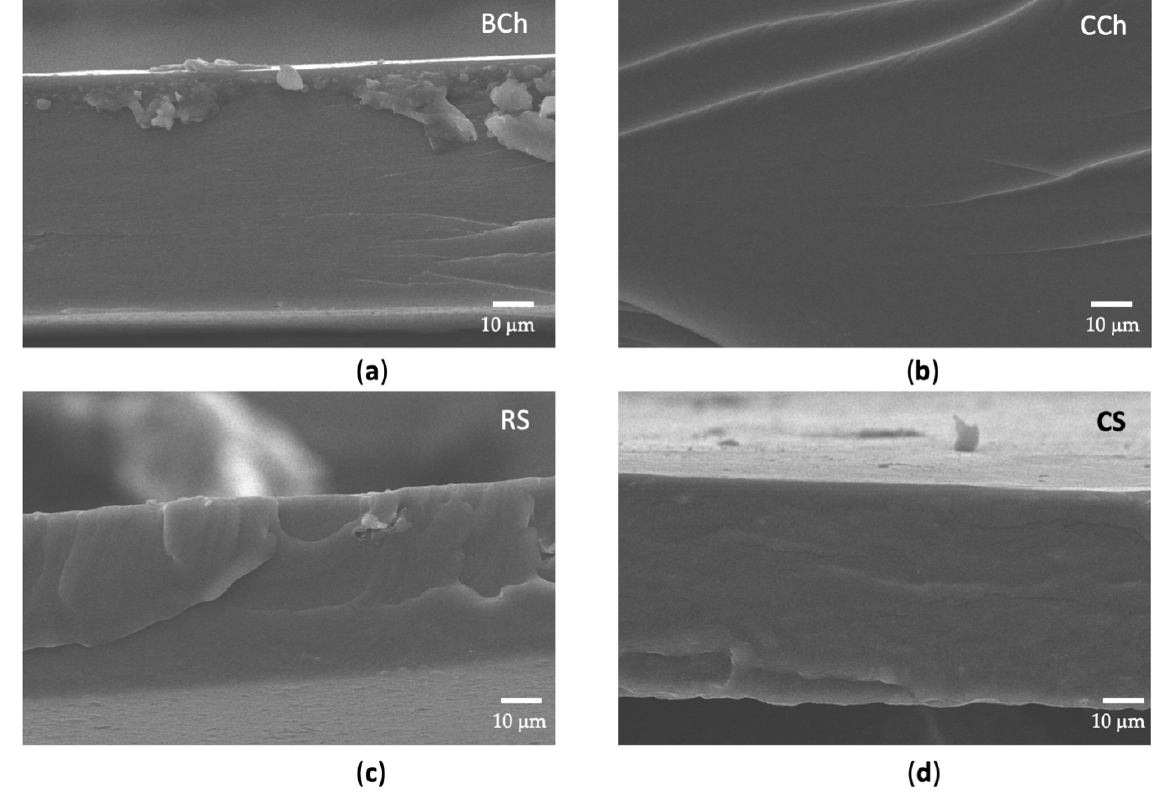
Figure 2. SEM micrographs ( a ) BCh, ( b ) CCh, ( c ) RS and ( d ) CS films.